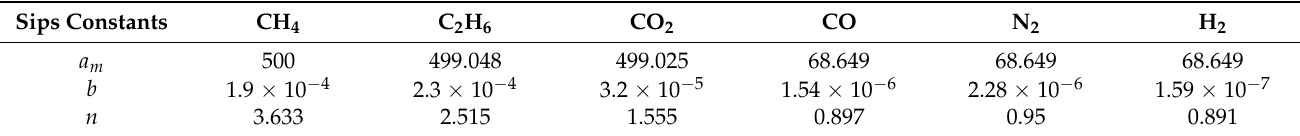
Table 1. Fitting parameters of Sips